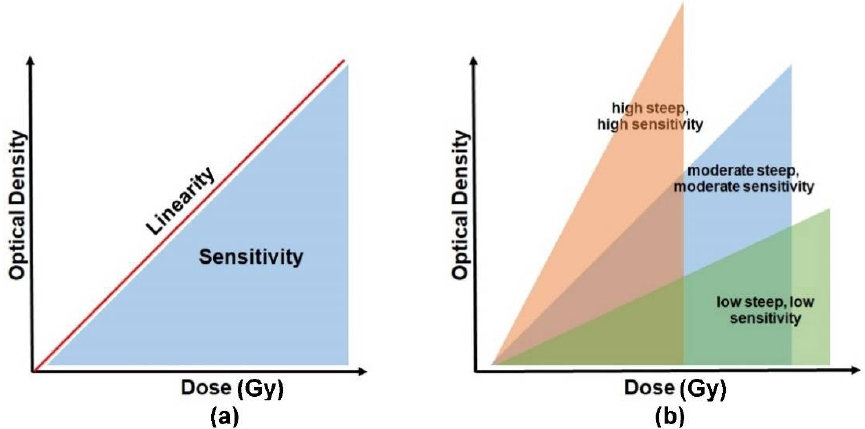
Figure 5. The basic concept to interpret the sensitivity and linearity of PRESAGE. Diagram ( a ) represents a relationship between the sensitivity and the linearity. ( b ) The degree of sensitivity is illustrated by the slope of the optical density vs. the absorbed dose.